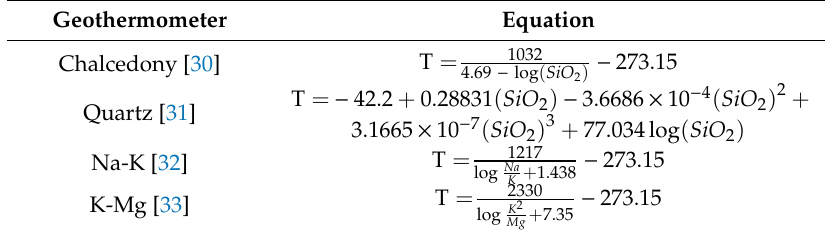
Table 1. Temperature equations (in ◦ C) for geothermometers used in this study. Concentration units for the elements are in mg /